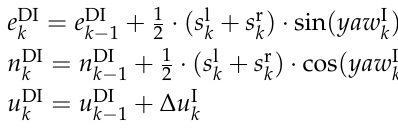
Δ is denoted as